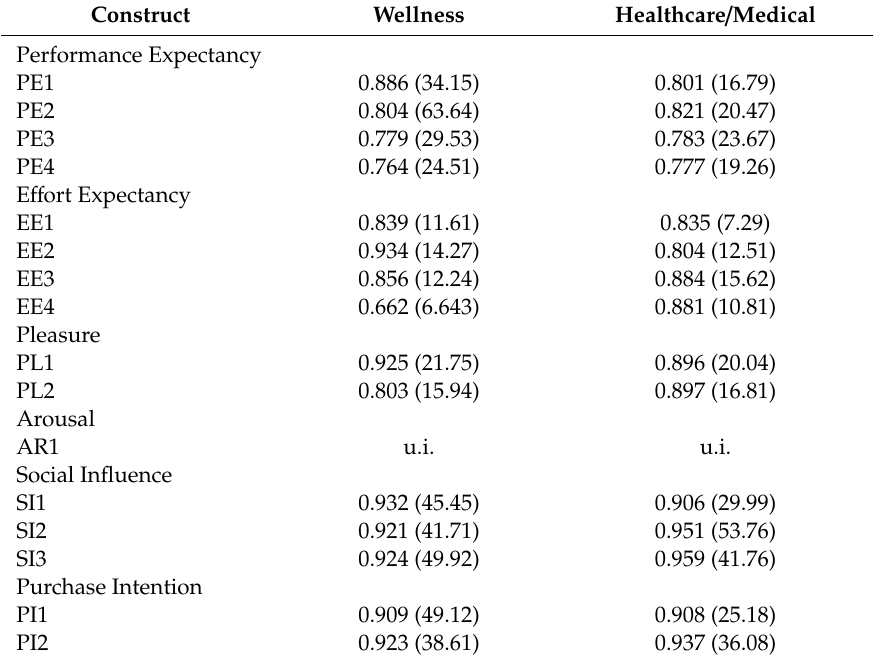
Standardized loading values ( t -values) of the Cognitive-A ff ective-Normative (CAN) dimensions and purchase intention for wellness and healthcare / medical